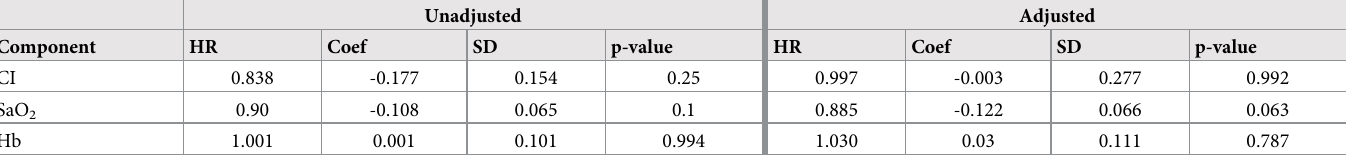
Table 2. Individual component of DO 2 I. Component